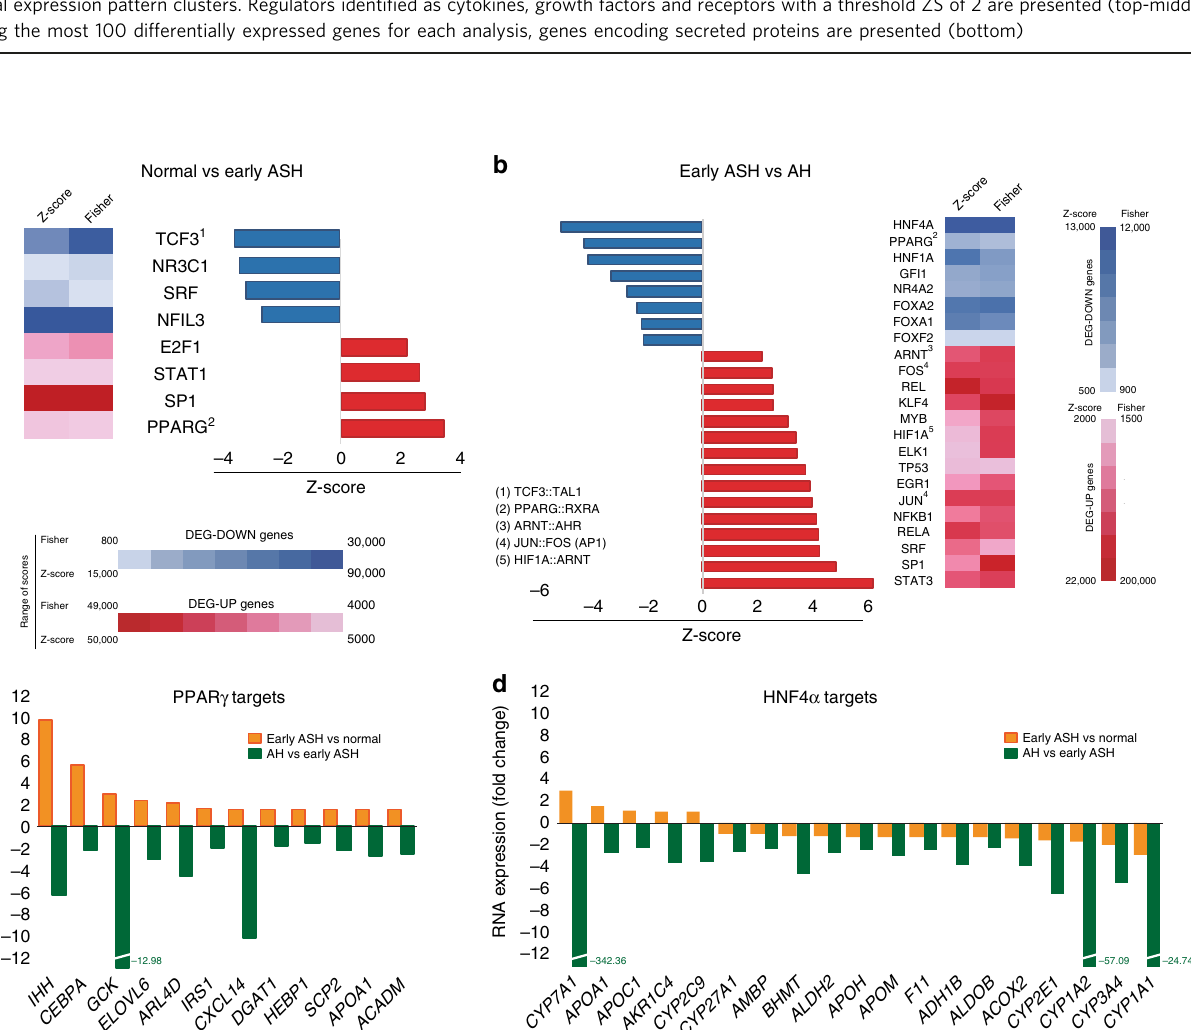
Fig. 2 The predicted activity of liver-enriched transcription factors is defective in AH patients. a , b Transcription factor transcriptomic footprint inferred using Ingenuity Pathway Analysis (IPA) and Opossum analyses. Top differentially expressed (DE) genes between a normal livers and early ASH and b between early ASH and AH patients were the input for these analyses. Blue/Red indicates predicted activation/inhibition or motif enrichment in top 2000 downregulated/upregulated DE genes. c Selected target genes of PPAR γ identi fi ed by IPA analysis. d Selected target genes of HNF4 α identi fi ed by IPA analysis. Fold Changes (FC) in Normal vs Early ASH and between Early ASH and AH are presented. All genes in g and h had a FDR <10 − 6 in DE and Hep3B cell lines (mean of 33 vs 37 and 38 cycles, respec-